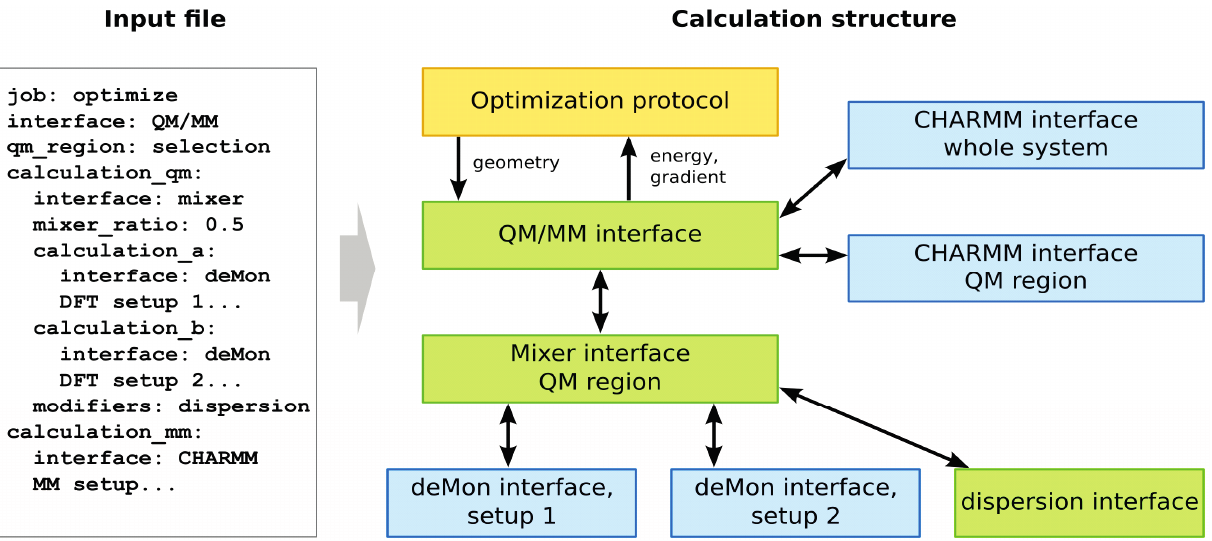
Figure 9. Structured input for Cuby (detailed setup for each module omitted for clarity) defines the structure of the Cuby calculation built from independent modules: the optimization driver (yellow), interfaces providing/combining calculations within Cuby (green) and interfaces to external software